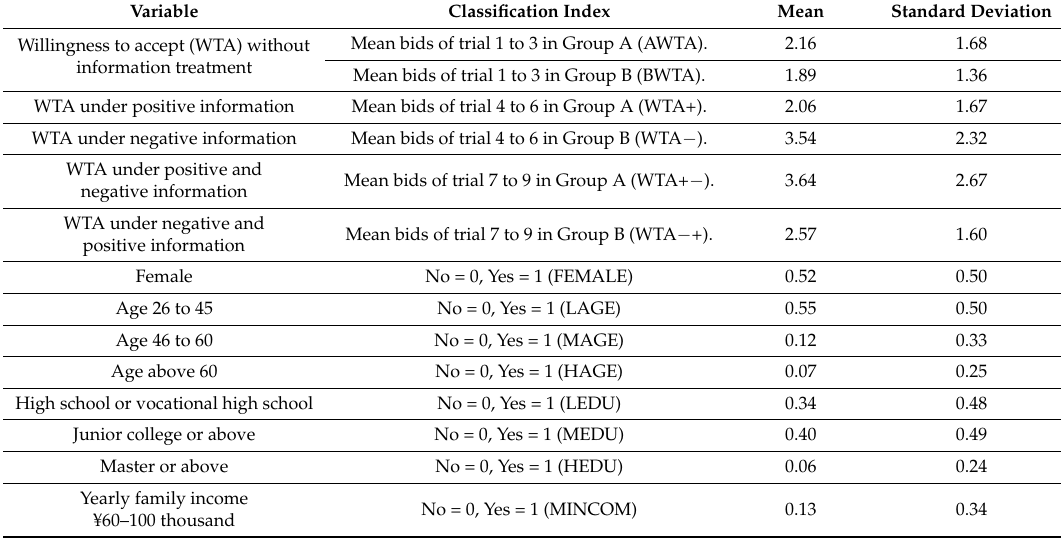
Table 3. The variable index determination for the Tobit